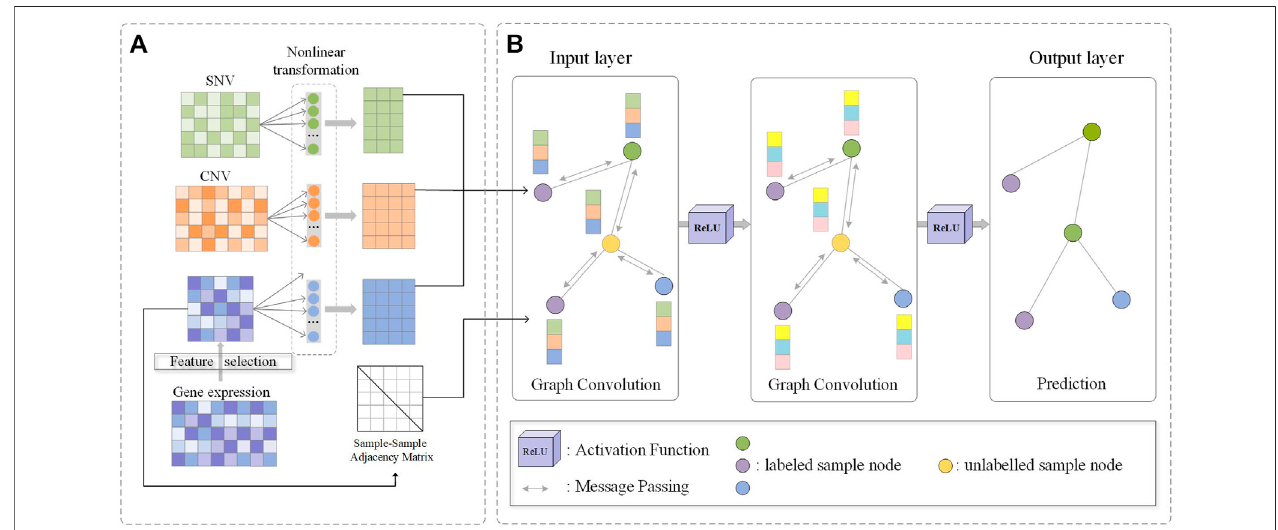
FIGURE 1 | Flowchart of M-GCN. (A) Filtered SNV and CNV features and molecular subtype-related transcriptomic features selected by HSIC Lasso are used as the input.Three type-speci fi cnon-lineartransformation layersareused.The sample – samplesimilaritygraphisconstructed bymolecular subtype-related transcriptomic features. (B) Output of non-linear transformations and sample – sample similarity graph are used as the input of GCN; convolution process is used for message passing and aggregation among samples; output of the fi nal GCN layer is the prediction of samples ’ subtype category.